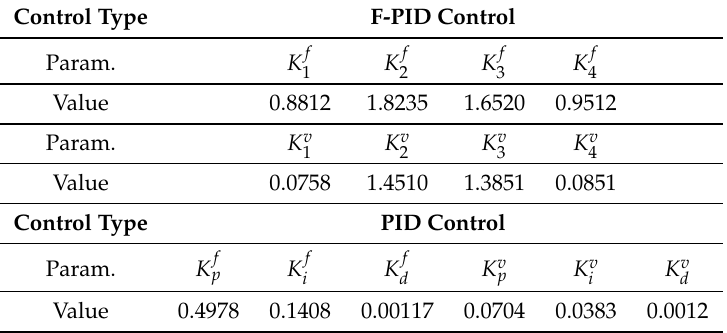
Table 1. Control gains of fuzzy proportional integral derivative (F-PID) and PID controllers optimized by salp swarm algorithm (SSA).